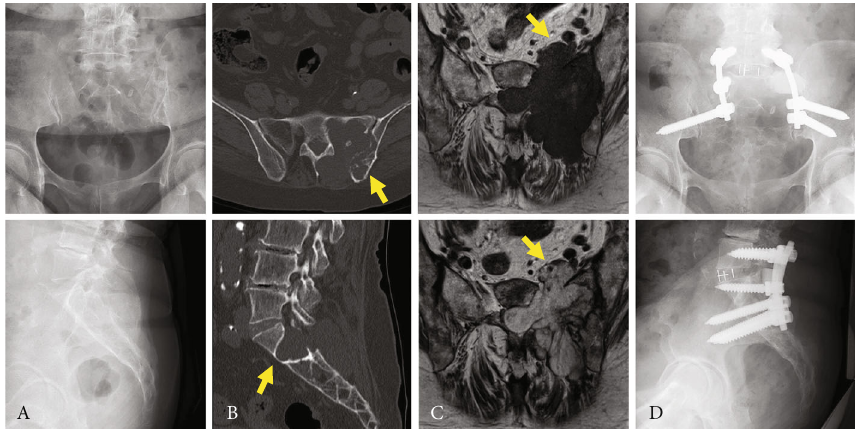
Figure 1: Chondrosarcoma in a 75-year-old woman. A plain radiograph showing a poorly speci fi c fi nding in the sacrum (A). Computed tomography showing destruction of the bone in the left posterior ilium (arrow) ((B), top). The anterior cortex of the S1 vertebra was scalloped (arrow) ((B), bottom). Magnetic resonance imaging shows a lobulated lesion with homogenous low signal intensity on a T1- weighted image ((C), top) and high signal intensity on a T2-weighted image. The septal structure of each lobulated lesion had slightly low signal intensity on T2-weighted imaging ((C), bottom). The tumor is protuberant with a dumbbell shape in the enlarged S1 anterior foramen (arrows) (C). Plain postoperative X-ray radiograph, showing fi xation of the L5-S-ilium